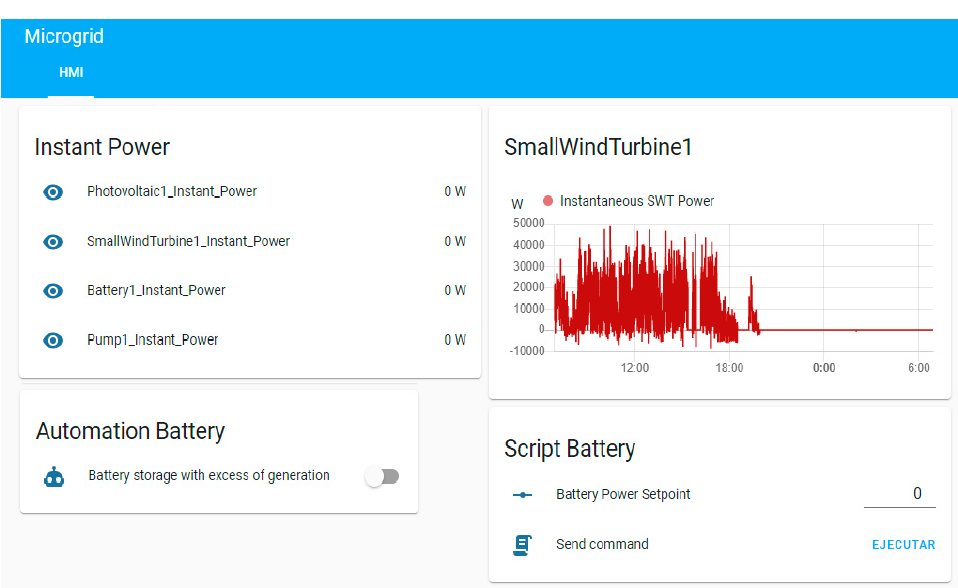
Figure 3. Home Assistant control panel. Source: prepared by authors.